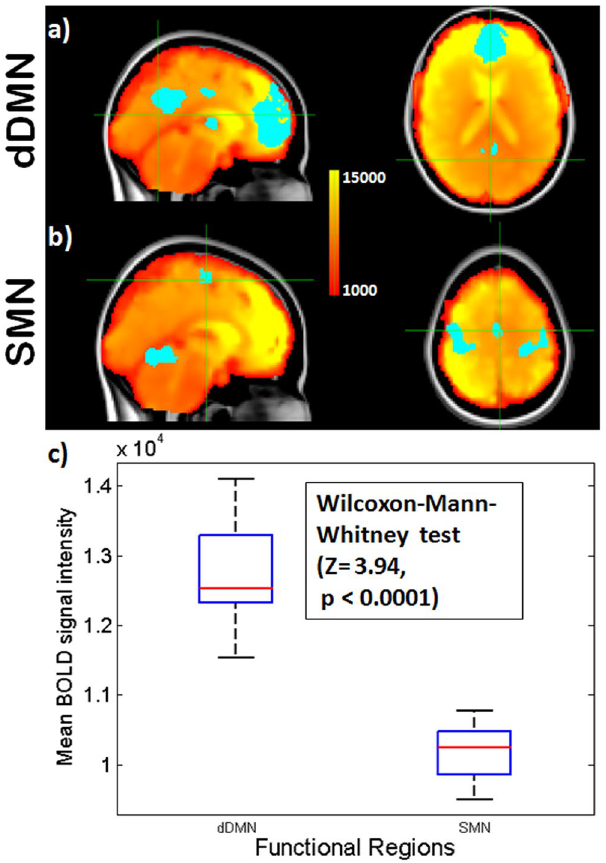
Figure 4. fMRI BOLD signal within the dDMN and SMN. Resting state mean BOLD image of an exemplary subject with masks of the functional regions of the ( a ) dDMN and ( b ) SMN overlaid on MNI 152 atlas (upper two rows). ( c ) The boxplot shows the mean BOLD signal in within the dDMN and SMN for 11 subjects. During rest the BOLD signal is higher in the dDMN than in the